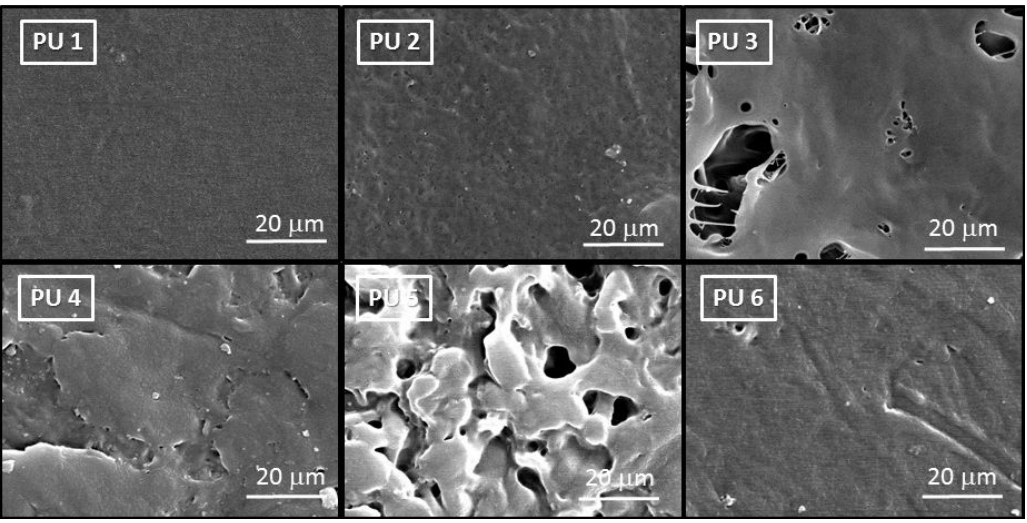
Figure 4. SEM pictures of samples PU 1–6 for visualization of the morphology.